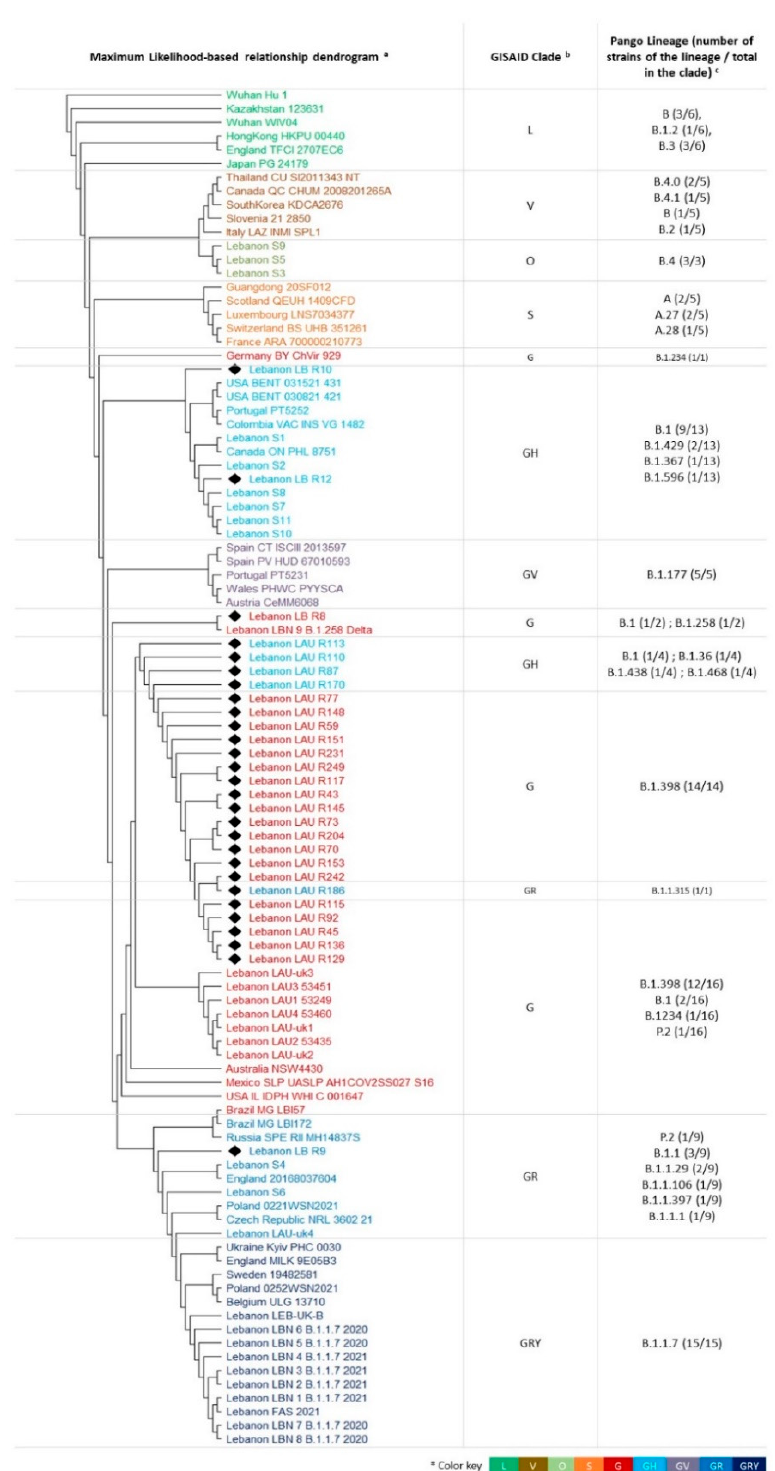
Figure 3. Phylogenetic tree representing the relationship among the 58 Lebanese SARS-CoV-2 and 41 reference genomes: ( a ) Using MegaX, genome sequences were first aligned with MUSCLE, and the relationship tree was established via maximum likelihood, with a bootstrap value of 500, followed by a rooting on Wuhan-Hu-1; ( b ) SARS-CoV-2 strains grouping according to the GISAID clades; ( c ) the various Pango Lineages within a certain cluster: the number of each lineage over the total number of strains within a cluster is shown. Color key is shown in the bottom right corner.